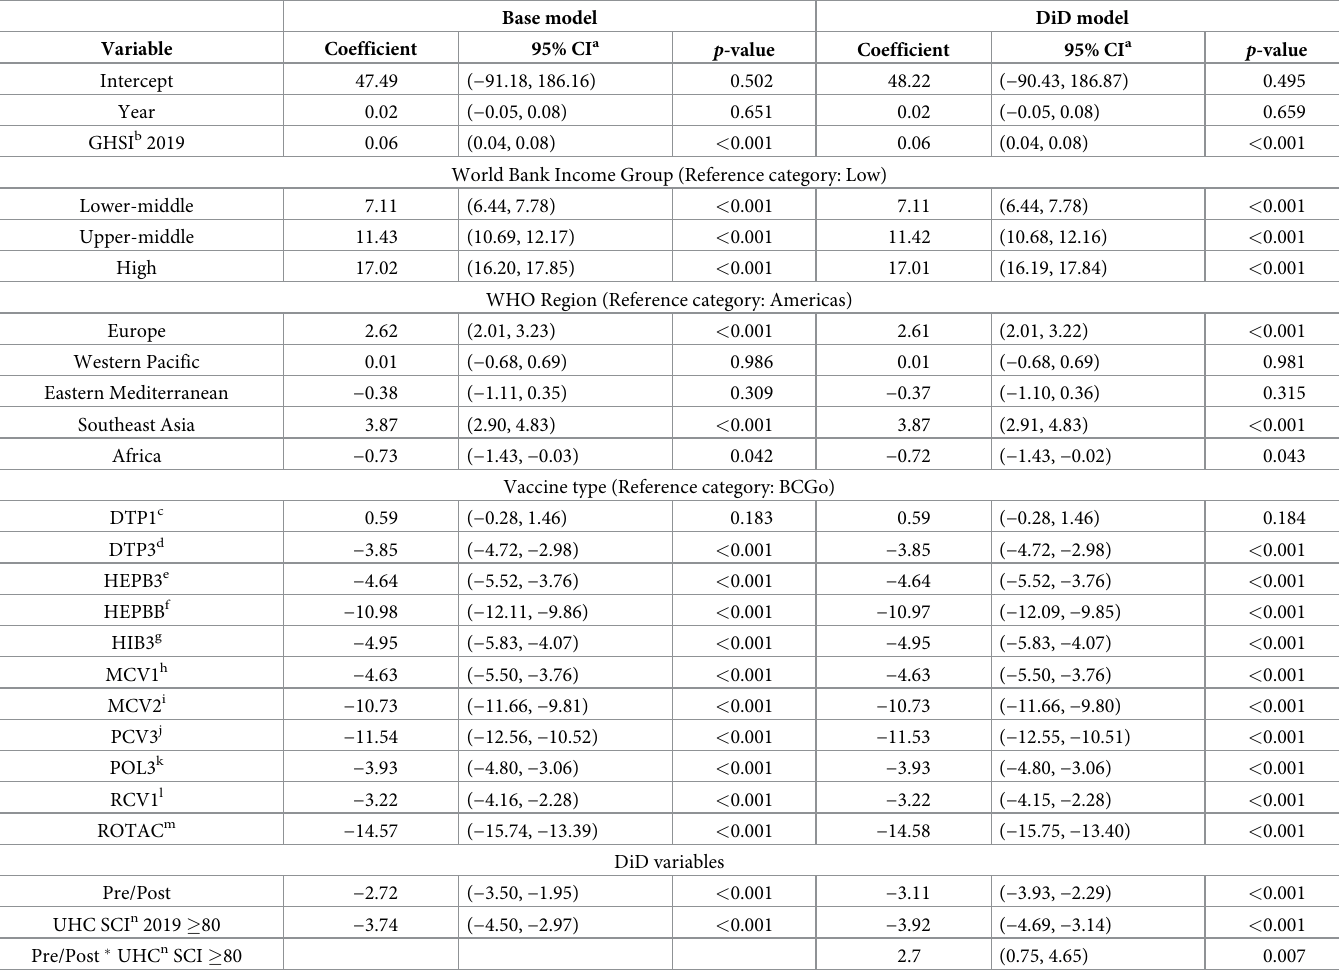
Table 3. DiD analysis results of countries with high UHC index values (UHC SCI � 80) vs. all other countries (UHC SCI < 80) in childhood immunization coverage in pre-pandemic period (2010–2019) compared with pandemic period (2020)—Adjusted for calendar year, pandemic preparedness, country income group, geo- graphic region, and vaccine